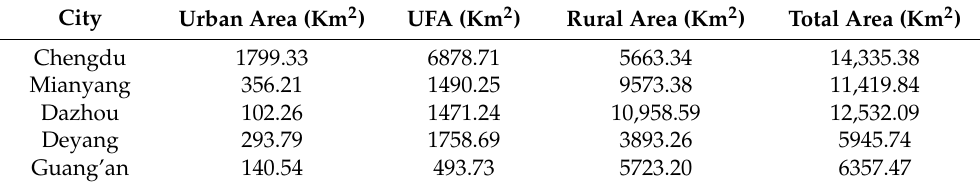
Figure 12. Areal proportions of urban areas, UFAs, and rural areas. Area of urban areas, UFAs and rural areas are shown in Table 3. Table 3. Area of urban areas, UFAs and rural areas. Areas are retained to two decimal